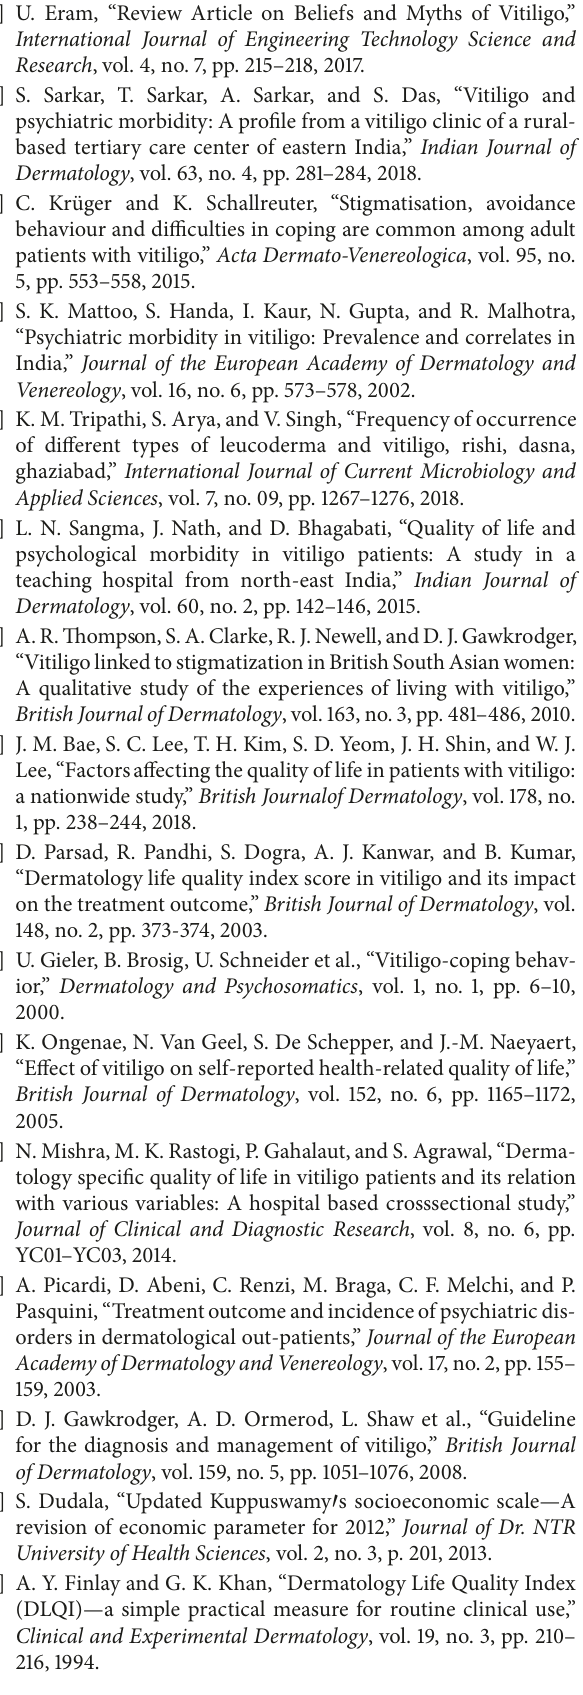
vitiligo: Results from a national survey indicate